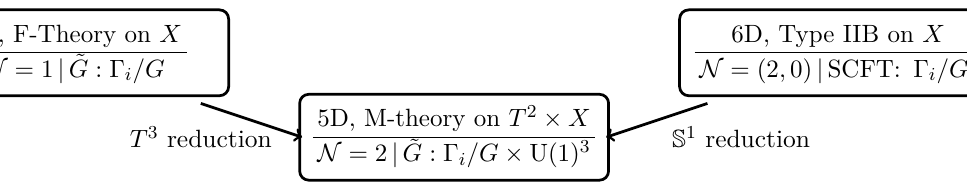
Figure 1 . Depiction of M-theory duality chain leading to the same 5D N = 2 supersymmetric theories. The same theory is obtained from T 3 compactification of F-Theory an elliptic K3, X with non-simply connected gauge group and a circle reduction of IIB on the same singular K3 with a gauged 2-form